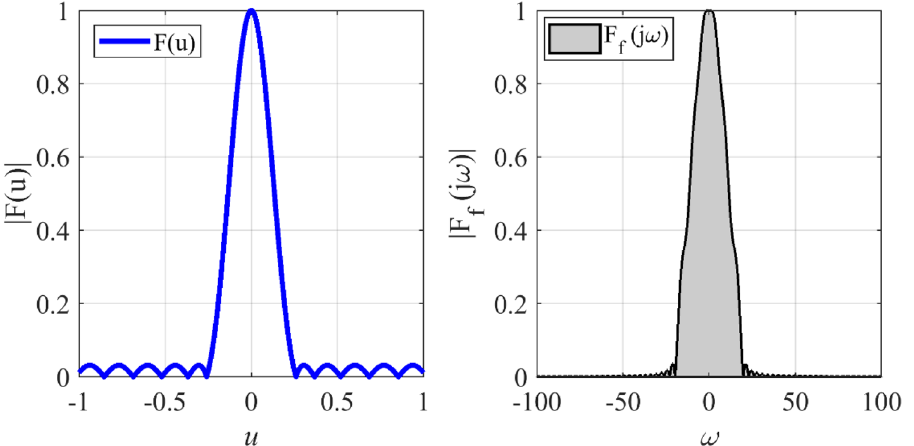
Figure 14. The desired pattern of the fifth case and its Fourier